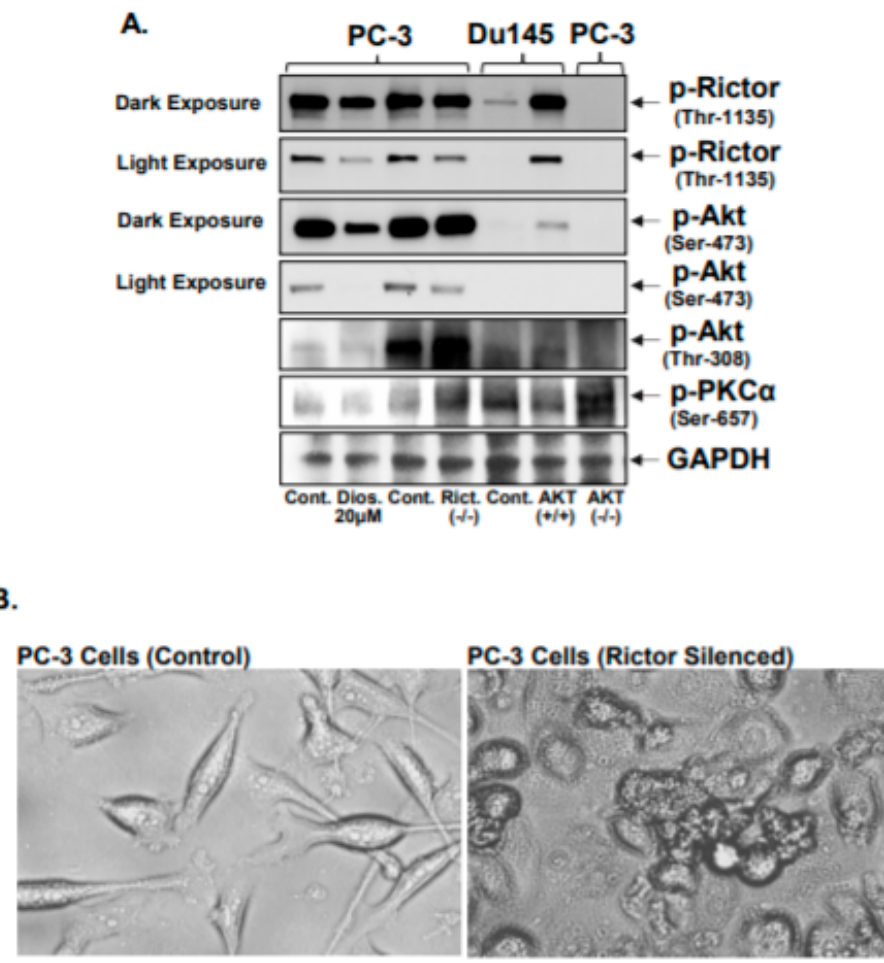
Figure 3. Effect of Rictor silencing in prostate cancer cells. Rictor (shRNA/ Lenti vector (Human) pGFP-iLenti) transfected in androgen-refractory PC-3 cells and Dominant Negative-AKT pUSEamp plasmid was transiently transfected to PC-3 cells, while DU145 cells were transfected with pLNCX vector containing AKT overexpression plasmid. After 48 h of transfection, total lysates were prepared. PC-3 cells were treated with 20 µ M diosmetin for 24 h, all the treated total lysates were resolved in SDS Page gel to observe the altered p-AKT (Ser-476), p-PKC α (Ser-657), and p-Rictor (Thr-1135) ( A ). Lanes mentioned as ‘Cont’ are control (cell lysate). For protein, control blots were stripped and reprobed with GAPDH. Microphotographs of PC-3 cells with Rictor silenced cells (transient transfection) ( B